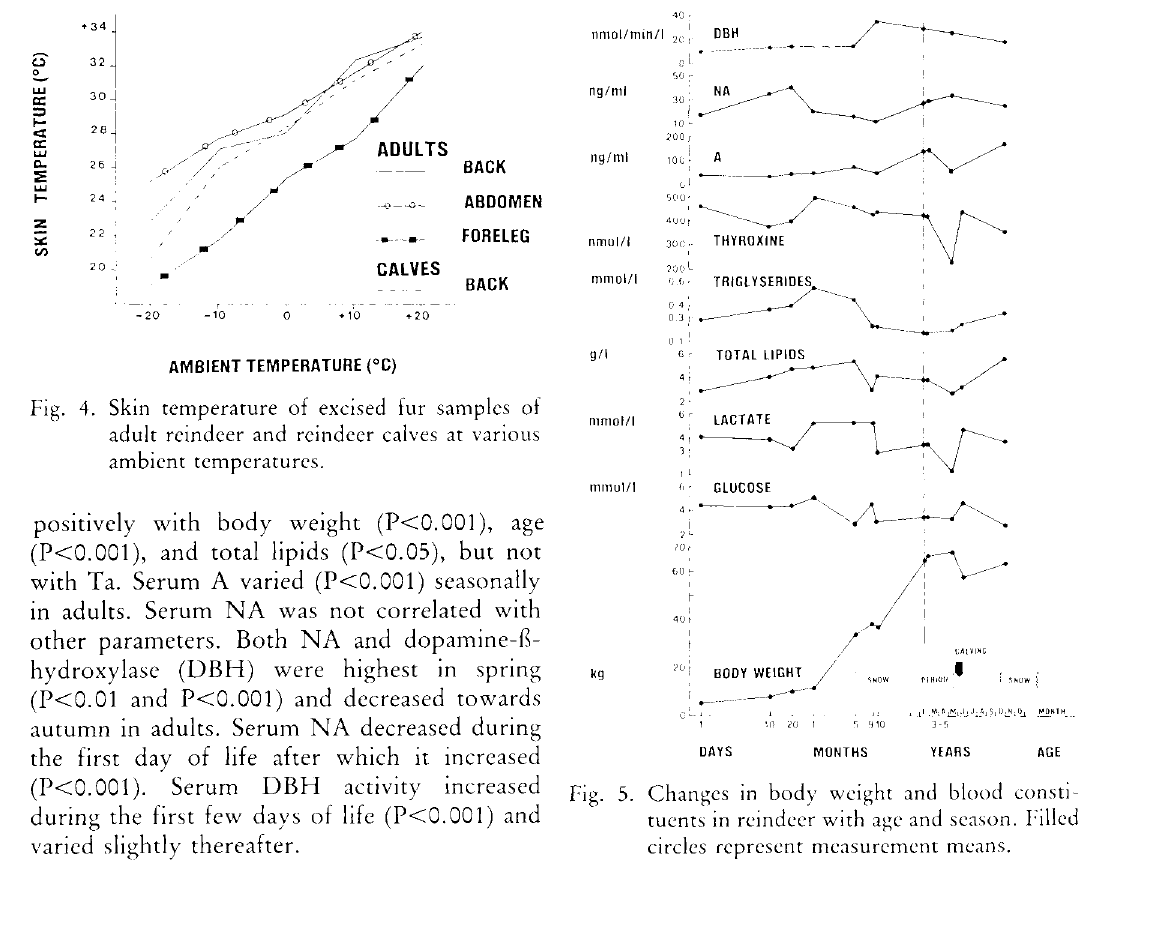
Fig. 5. Changes in body weight and blood consti tuents in reindeer with age and season. Filled circles represent measurement